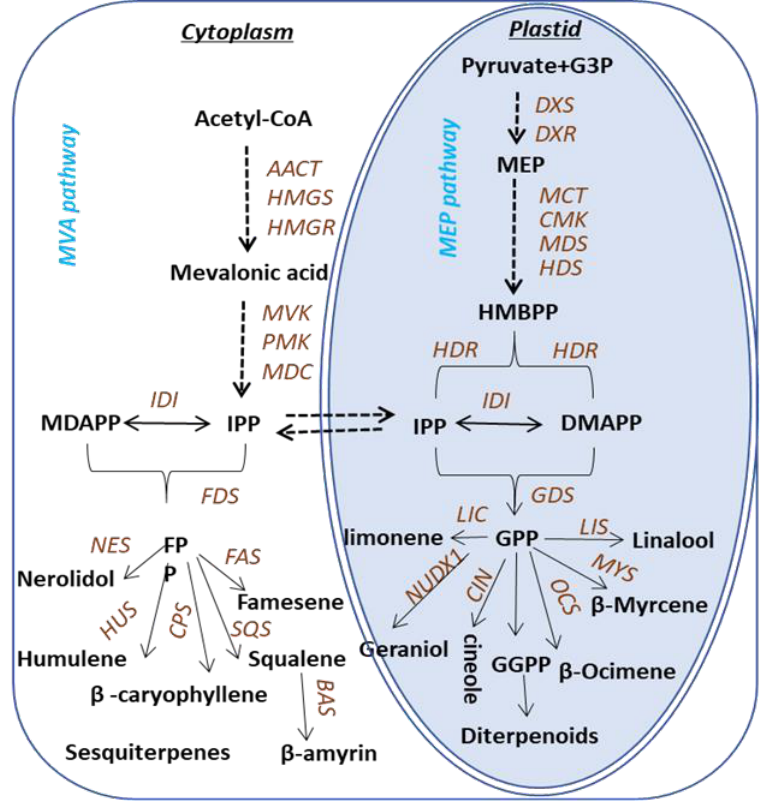
Figure 1. Pathway associated with terpene synthesis in Camellia sinensis. The following enzymes and compounds are involved in the MVA pathway: AACT, acetoacetyl-CoA thiolase; HMGS, 3-hydroxy-3-methylglutaryl- coenzyme (a synthase); HMGR, 3-hydroxy-3-methylglutaryl coenzyme (a reductase); MVK, mevalonate kinase; PMK, 5-phosphatemevalonate kinase; MDC, mevalonate-5-phosphate decarboxylase; IPP, isopentenyl pyrophosphate; IDI, isopentenyl pyrophosphate isomerase; DMAPP, dimethylallyl pyrophosphate. The following enzymes